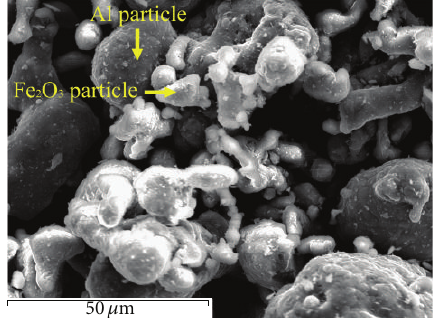
Figure 1: The pure Al/5 wt.%Fe 2 O 3 particle